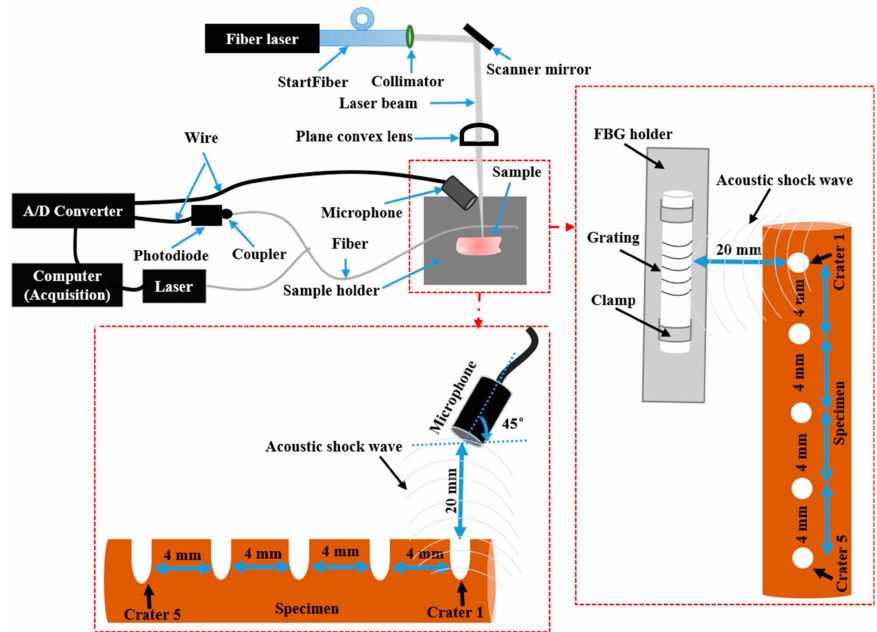
Figure 2. Schematic of the experiment illustrating the laser fiber set-up, an FBG and a microphone for laser-induced acoustic